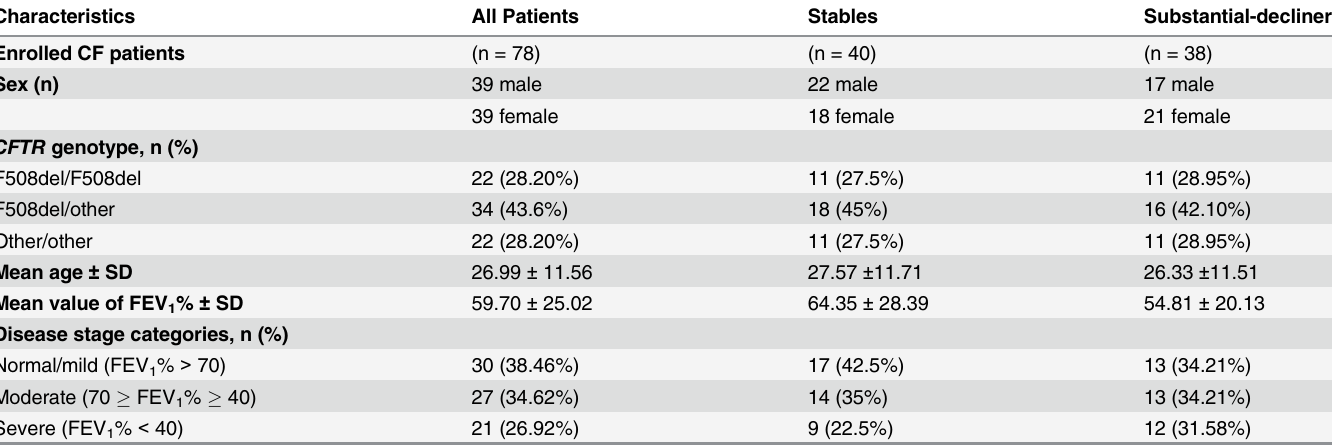
Table 1. Demographic and clinical characteristics of all participants and in stable (S) and substantial-decliners (SD)